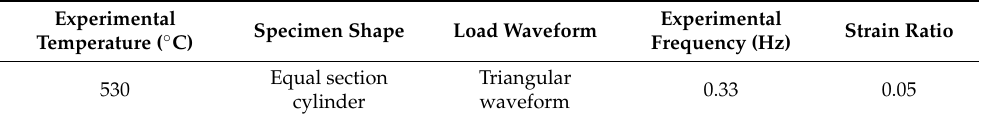
Table 1. Experimental conditions at 530 ◦ C.